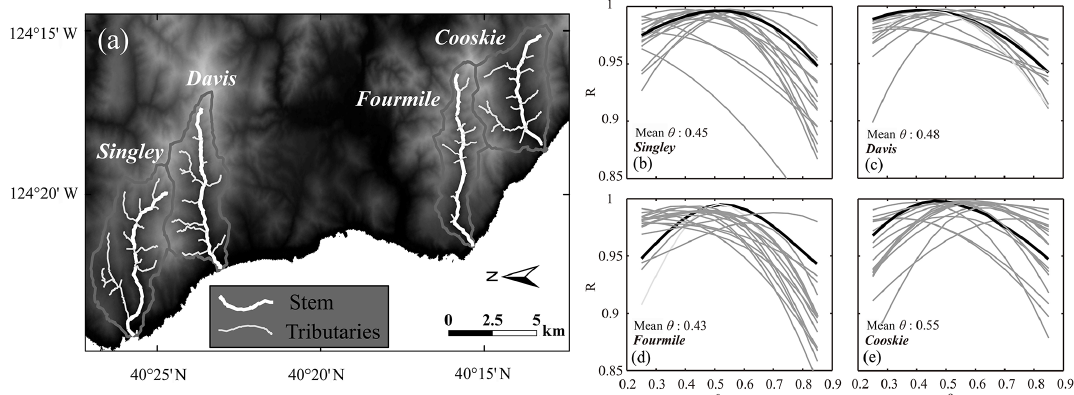
Figure 9. Correlation coefficients of χ − z plots as a function of θ . (a) Location of the streams. (b–e) Correlation coefficients of χ − z plots based on a range of θ values. Black thick lines indicate